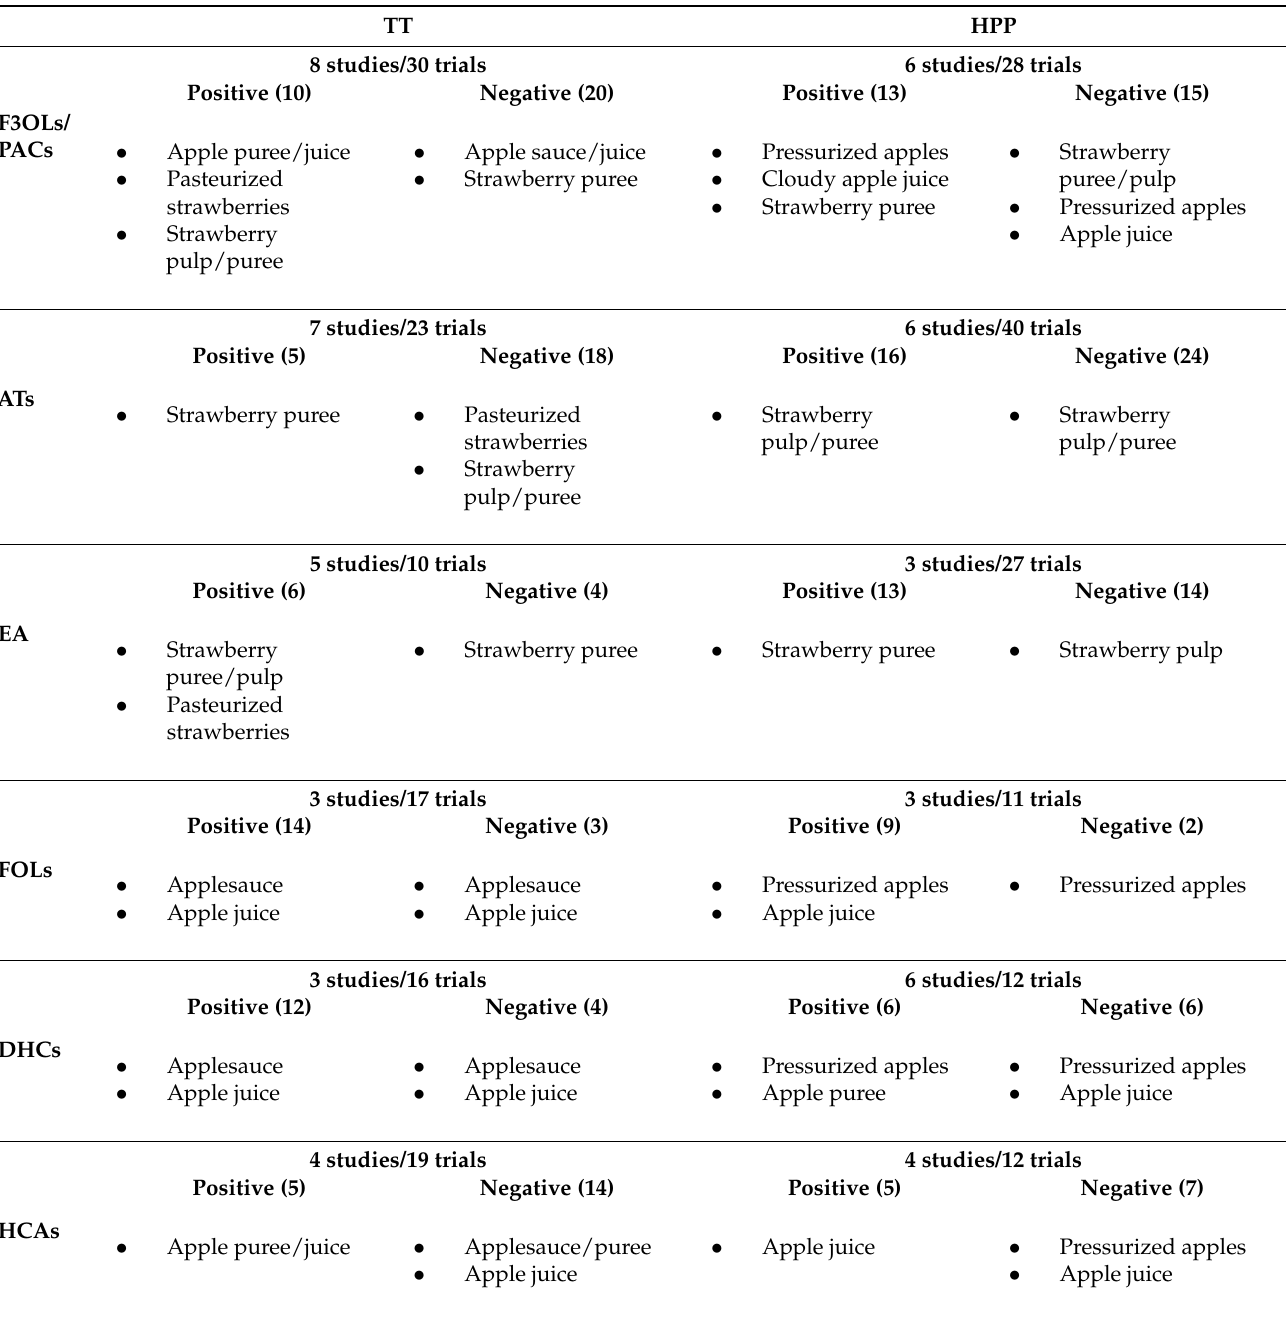
Table 3. Impact of TT and HPP treatments on different apple and strawberry phenolic compounds. (F3OLs/PAC) flavan- 3-ols + proanthocyanidins; (ATs) anthocyanins; (EA) ellagic acid; (FOLs) flavonols; (DHCs) dihydrochalcones; (HCAs) hydroxycinnamic